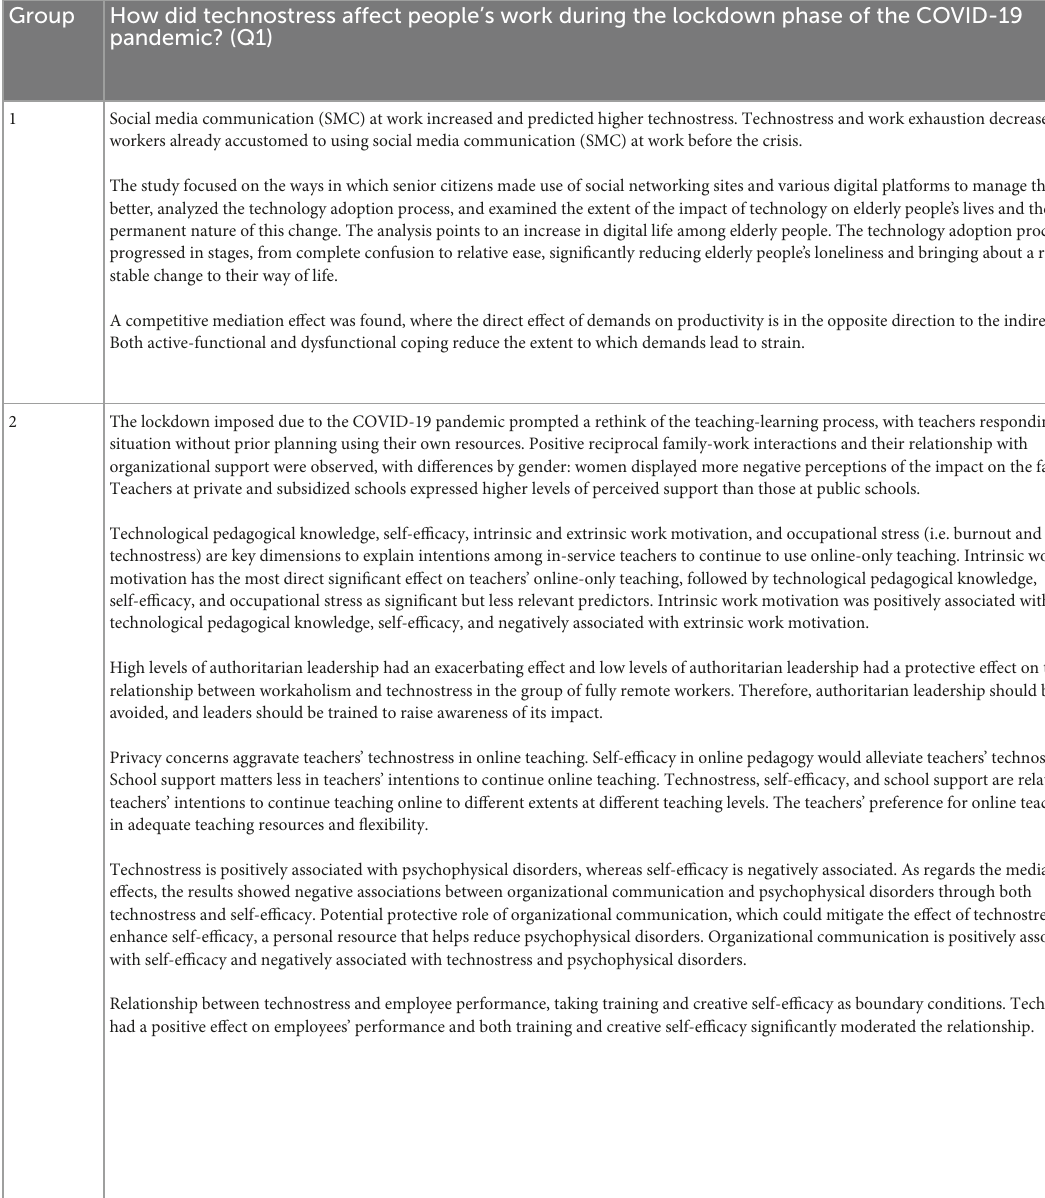
Studies providing evidence stressors affecting work of these impacts at the during the lockdown global level period? (Q2)